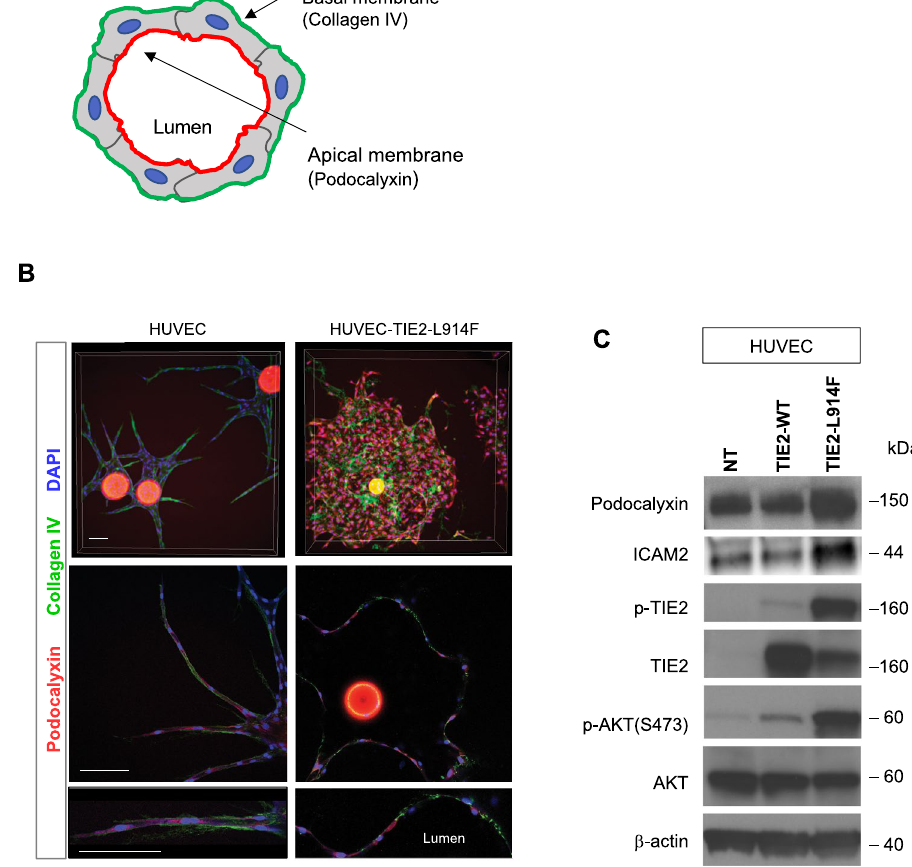
Figure 4. HUVEC-TIE2-L914F generate ectatic vascular channels with disorganized distribution of the apico-basal polarity markers Podocalyxin and Collagen IV. (A) Schematic of lumen apical and basal markers, respectively Podocalyxin and Collagen IV. ( B) HUVEC and HUVEC-TIE2-L914F –derived lumens in the fibrin gel were analyzed for the polarity markers Podocalyxin (apical/luminal marker) and Collagen IV (basal marker). Z-stack images (max projection) (top panels), single slice image taken in the center of the z-stack (middle panel) and zoom-in of single slice to show high magnification details of apical and basal polarity marker distribution (bottom panel). Scale bar: 200 μ m. ( C) Immunoblot analysis for the indicated antibodies of HUVEC, HUVEC-TIE2-WT and